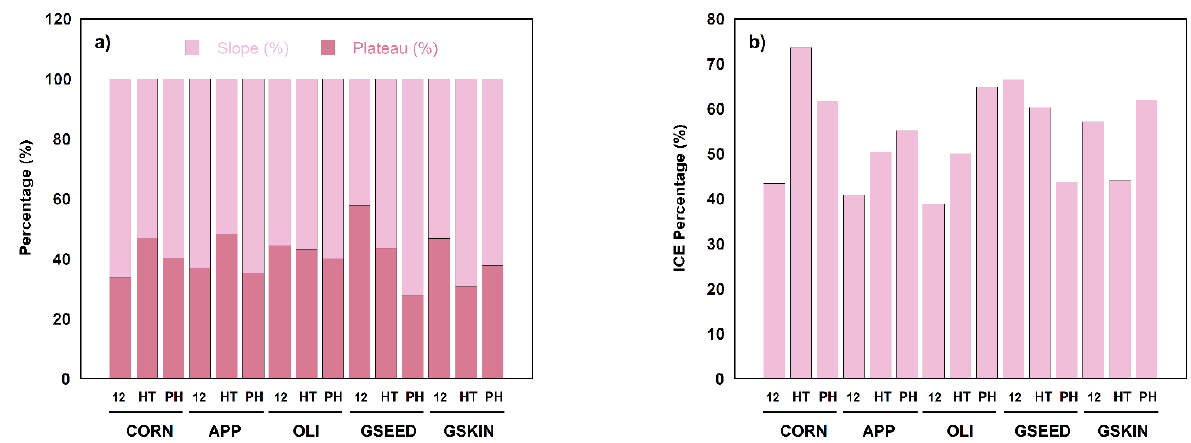
Figure 6. Slope-plateau proportion ( a ) and Initial Coulombic Efficiency (ICE) ( b ) in each material. Analysis of the ICE (Figure 6b) indicates that the use of HTC pretreatment and the combined pretreatment with AH improves the ICE values compared to the pyrolytic ones, reaching at least 50% of ICE for most of the precursors (CORN, APP, OLI and GSKIN). However, GSEED and GSKIN do not show this trend and, in these cases, ICE values higher than 55% are only reached by using direct pyrolysis and HTC pretreatment (GSEED) and direct pyrolysis and the AH combined with HTC pretreatment (GSKIN). It